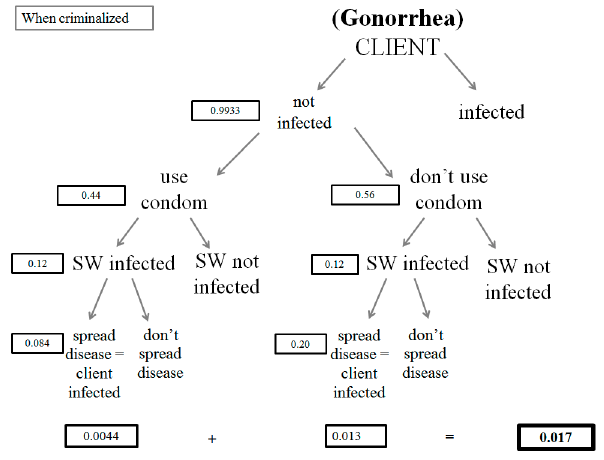
Figure A14. Risk of gonorrhea transmission to a client under criminalization.